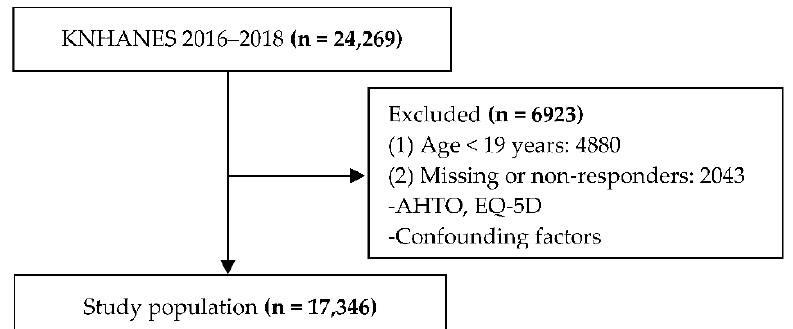
Figure 1. Flow diagram illustrating participant selection.